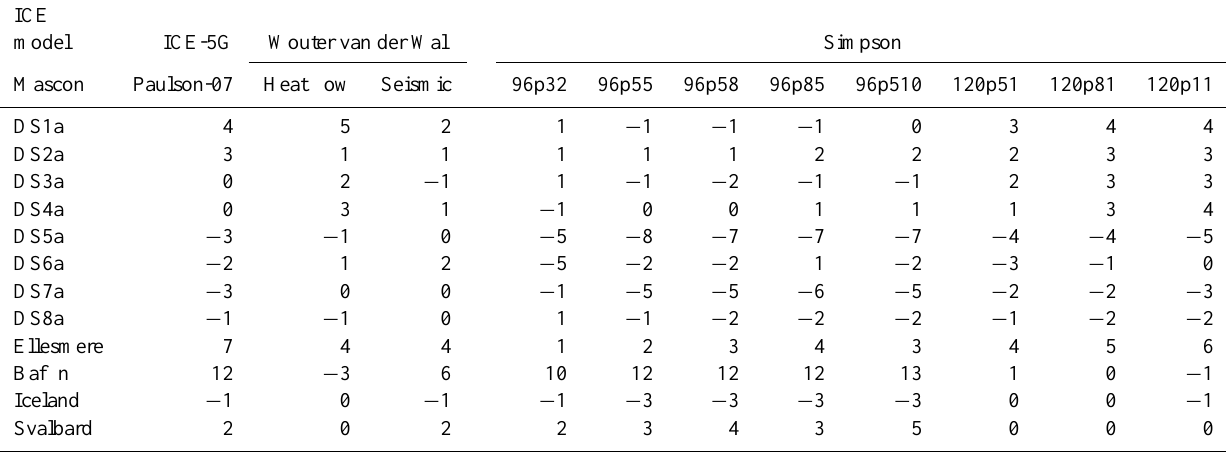
Table A3. The GIA effects on mass balance in different GrIS regions based on 11 different GIA models. The unit is Gtyr − 1 . For the GIA models using Simpson’s ice history model, the column headers are in the form of “ x pa b ”, where the x value refers to the lithosphere thickness (km), and a and b represent the viscosity of the upper and lower mantle, in 10 20 and 10 21 Pas, respectively.